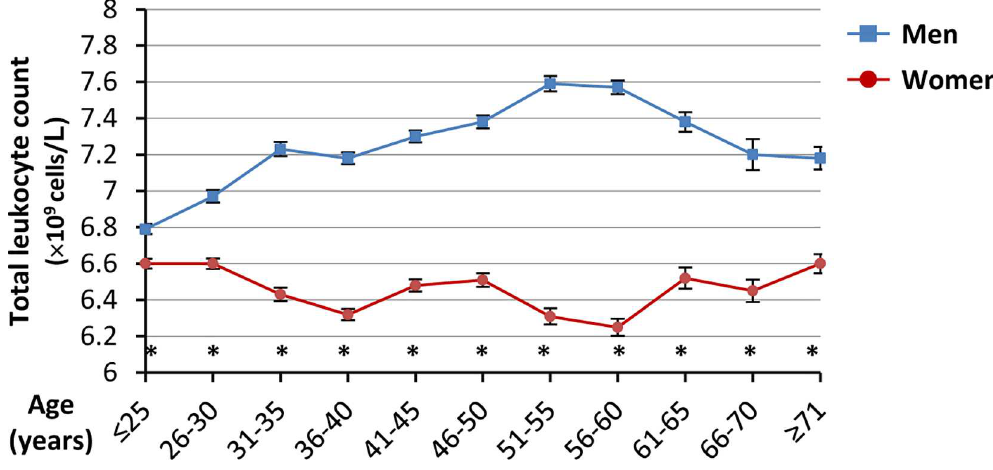
Fig 1. Total leukocyte counts in men and women in different age groups. Data shown are mean ± standard error of mean in men and women, respectively, in each age group; * indicatesp < 0.05 comparingmen and women in the respective age